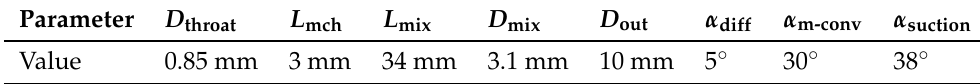
Table 1. Main dimensions of the ejector geometry with dimensions as defined in Ringstad et al. [57].